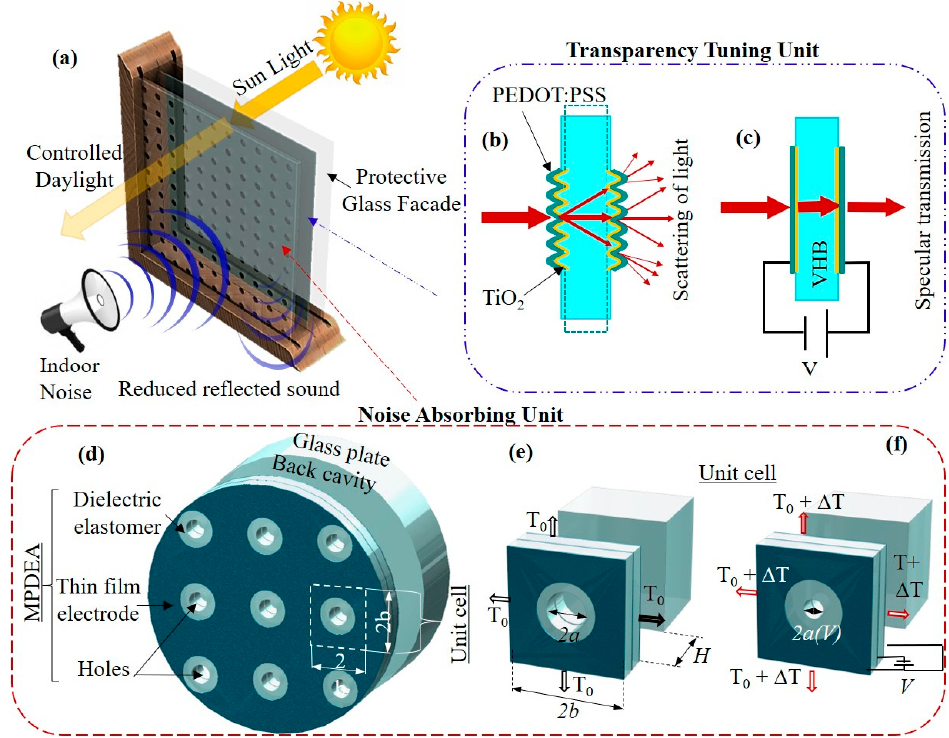
Figure 1. ( a ) Schematic of the smart window made of two components, first component can tune its transparency and second can absorb noise while adapting to the varying noise frequency; Schematic of the transparency tuning device based on dielectric elastomer actuator (DEA) optical scatterer ( b ) optically scattering state at inactive state; ( c ) optically transparent state at activated state. ( d ) Schematic of the microperforated dielectric elastomer actuator (MPDEA) device; ( e ) magnified view of a hole of the MPDEA at the inactive state; ( f ) a hole of the MPDEA at activated state.